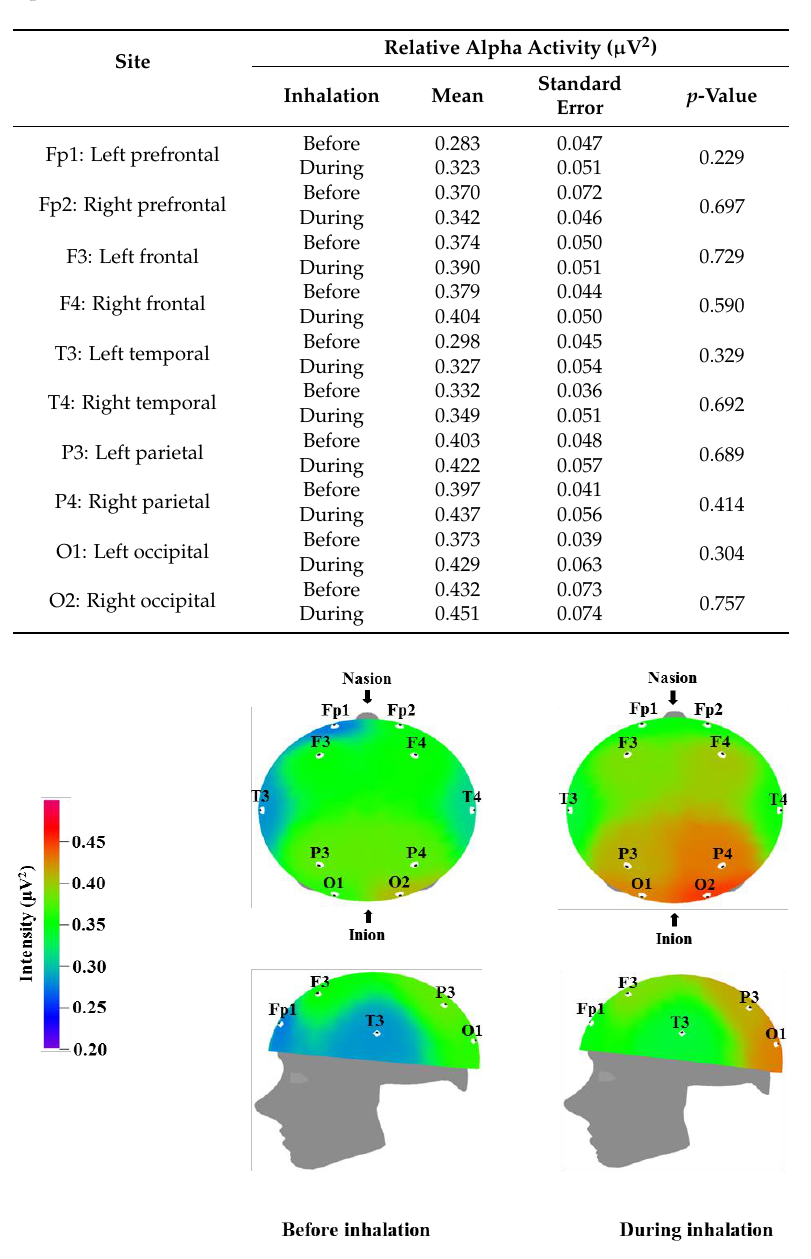
Table 4. Effect of inhalation of volatile organic chemicals (VOCs) from Chrysanthemum indicum Linné on relative alpha wave.